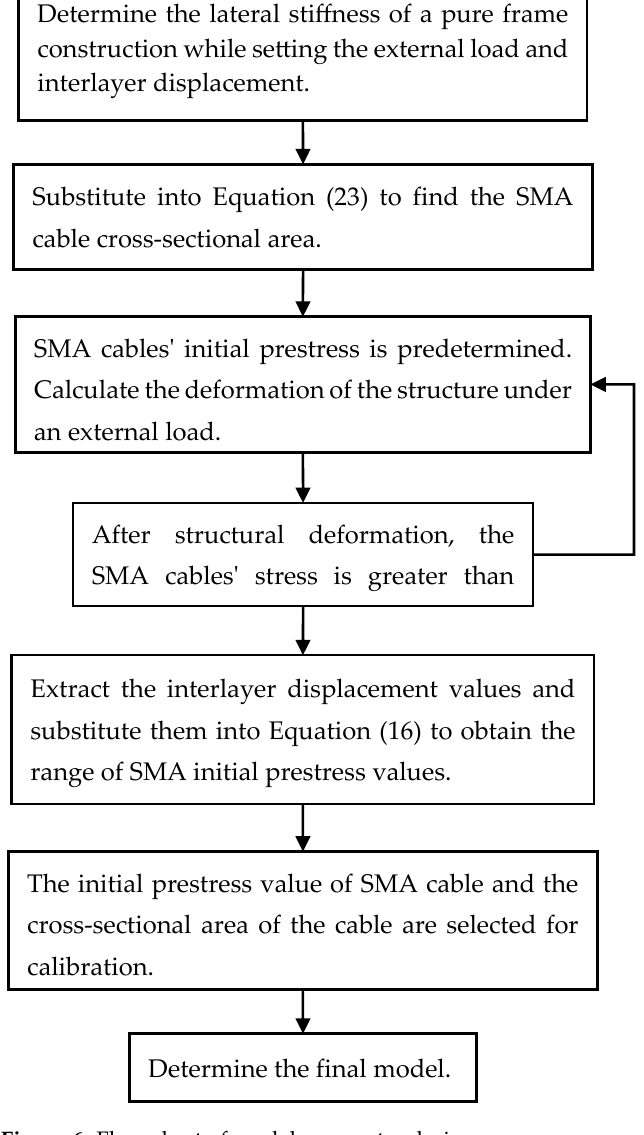
Figure 6. Flow chart of model parameter design.